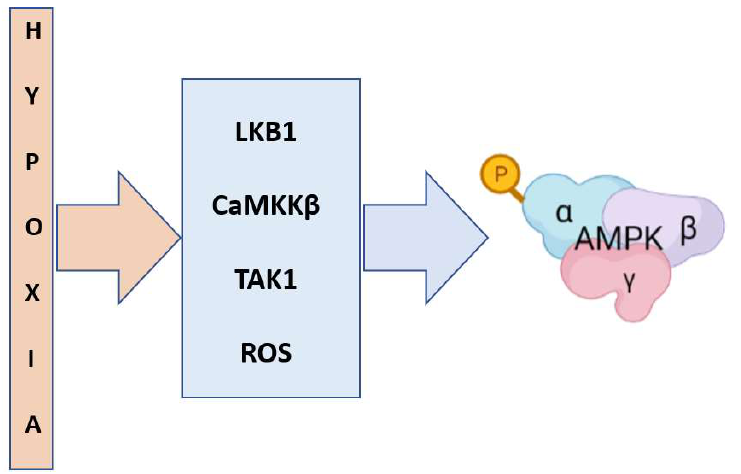
Figure 1. Upstream mediators implicated in AMPK activation by hypoxia.